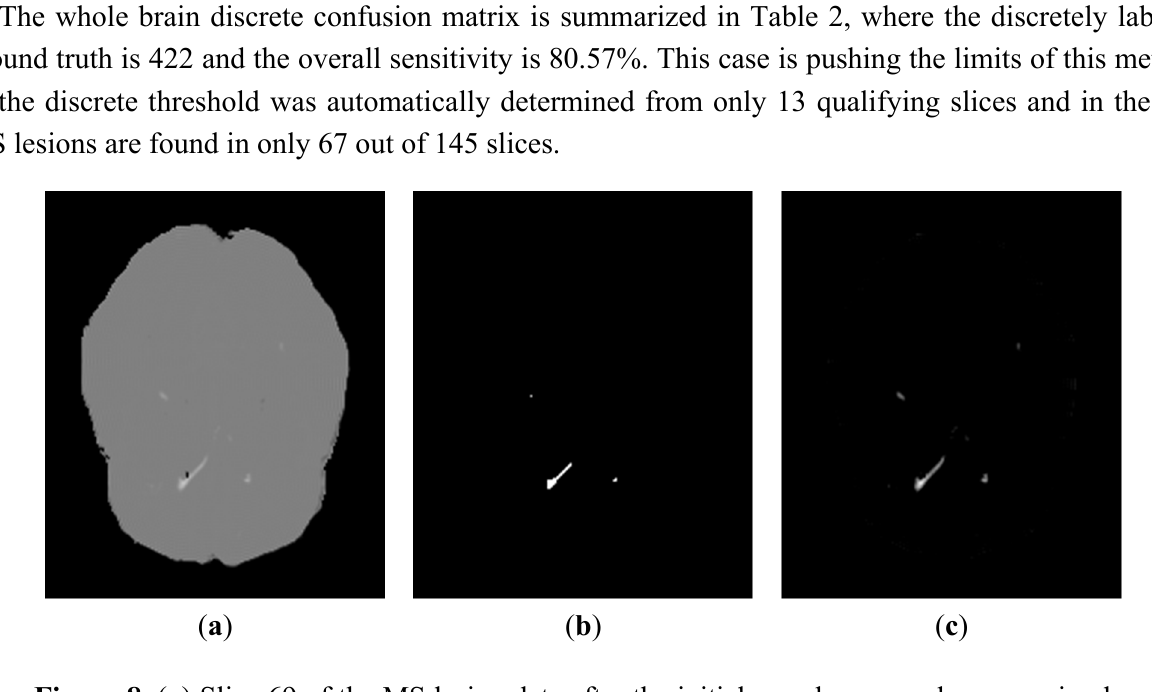
Figure 8. ( a ) Slice 69 of the MS lesion data after the initial pseudo-grayscale conversion